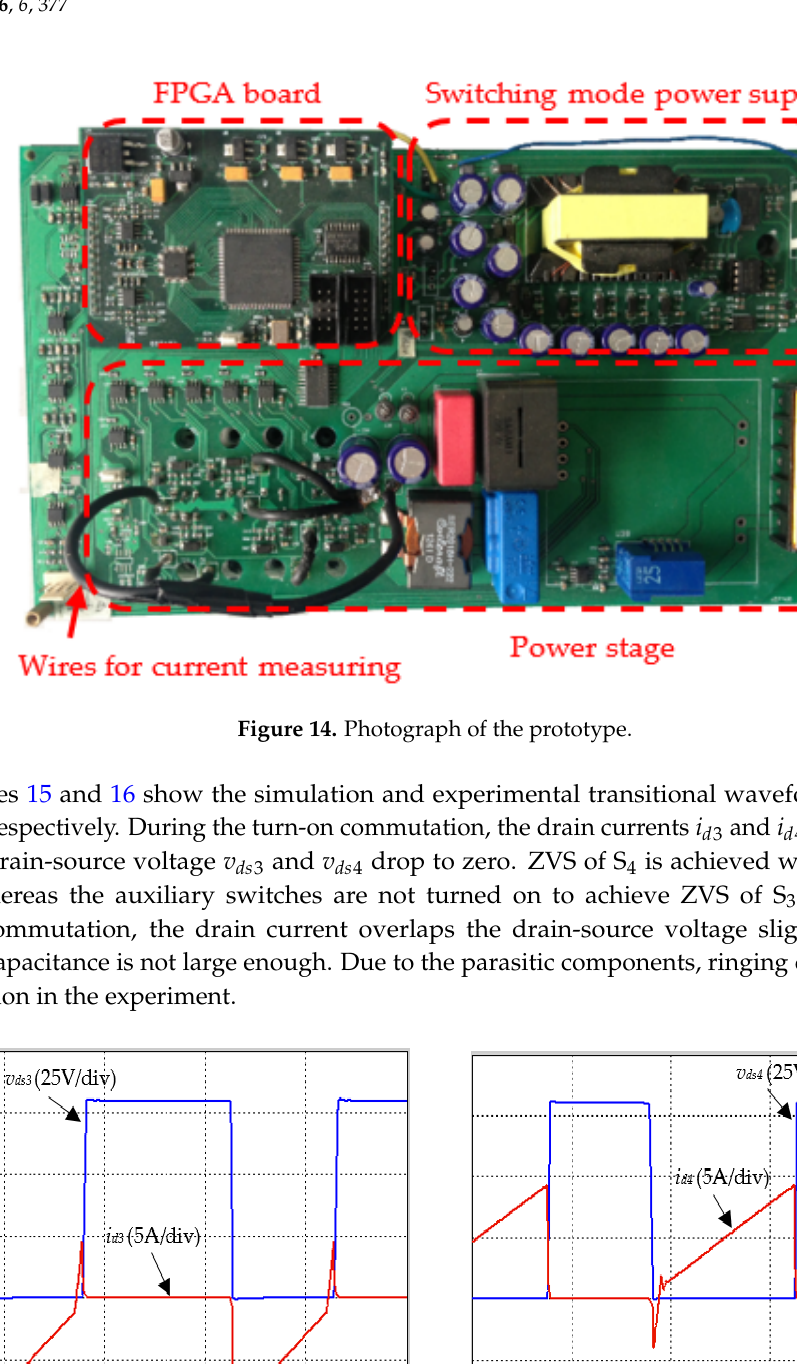
o = 8 A. ( a ) S 3 ; ( b ) S 4